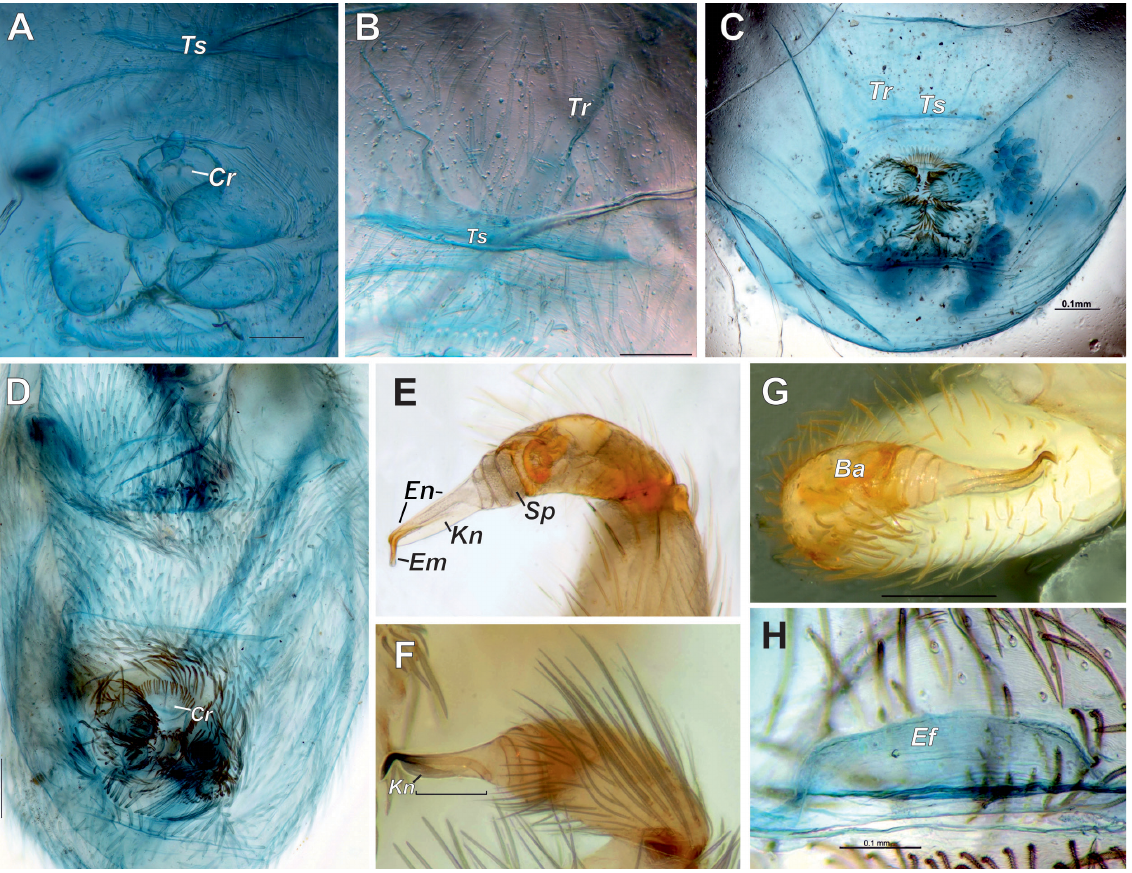
Fig. 3. Morphology of Zaitunia spp. A–B . Z. logunovi sp. nov., paratype, ♂. C . Z. schmitzi (Kulczyński, 1911), ♀ from Jerusalem area. D , H . Z . martynovae (Andreeva & Tyshchenko, 1969), ♀ from Gandzhina. E , G . Z. wunderlichi sp. nov., paratype, ♂. F . Z. beshkentica (Andreeva & Tyshchenko, 1969), ♂ from khurshedi. — A–D . abdomen, ventral. E–F . terminal part of palp, retrolateral. G . Same, dorsal. H . Genital area of subadult female. abbreviations: see Material and methods. Scale bars: a–B, D, G = 0.2 mm; C, H = 0.1